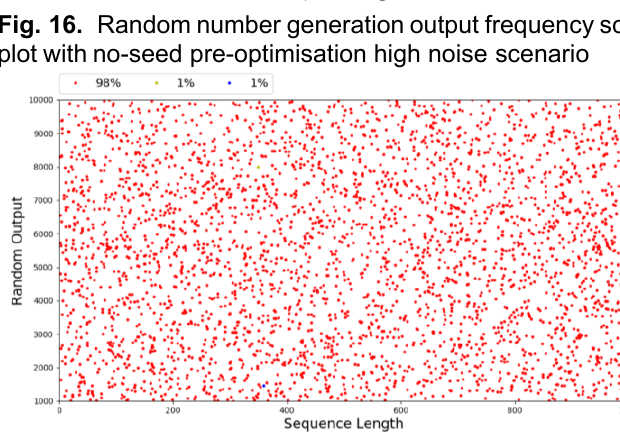
Fig. 14. Random number generation output frequency scatter plot with audio seed, pre- optimisation with no noise